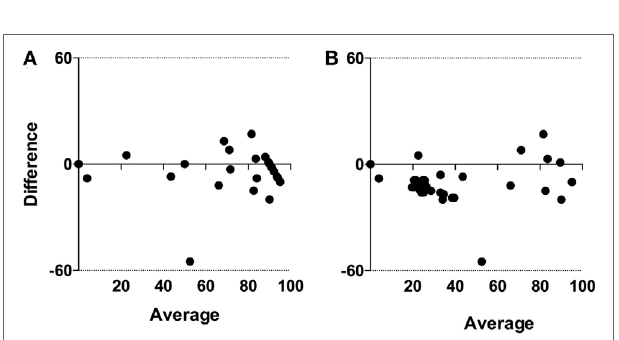
FigUre 3 | Bland–Altman limits of agreements between diagnostic tests based on (a) microscopy and (B) molecular detection. For graphical reasons, negative results with both molecular tests are replaced with a cycle threshold (Ct) value of 50.